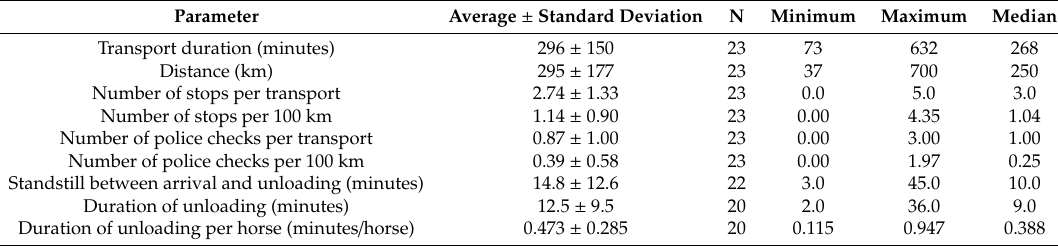
Table 6. Average transport duration, distance and average number of stops and police checks per transport and per 100 km. Duration of loading, unloading and standstill after loading and before